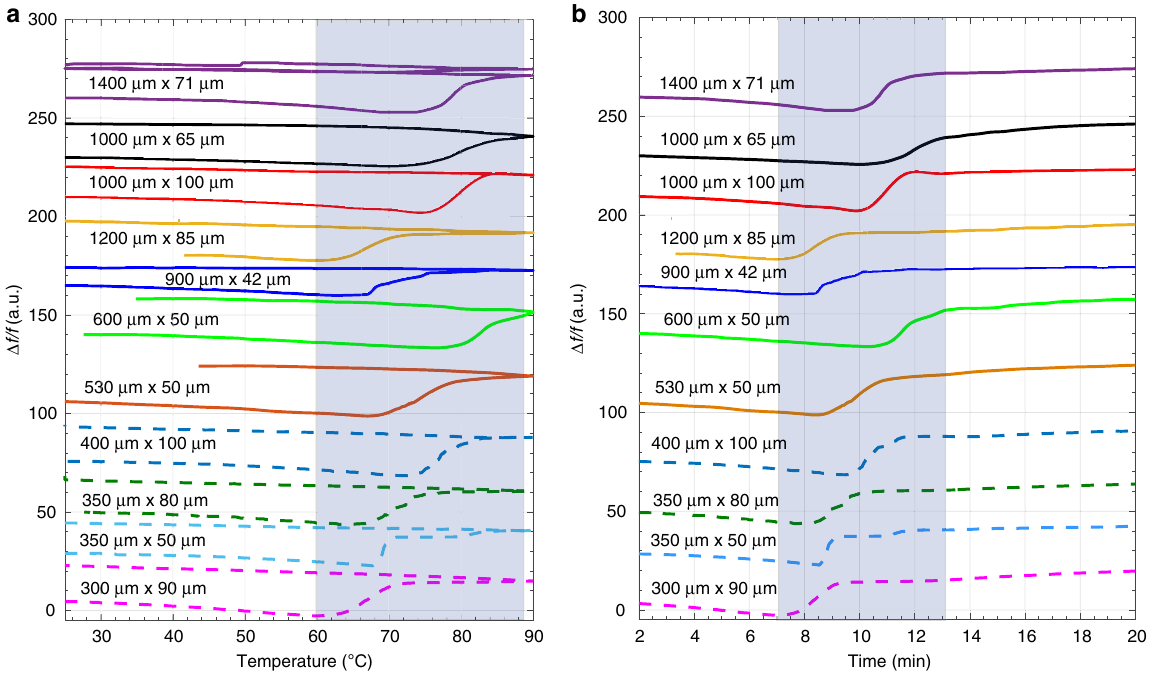
Fig. 4 Reproducibility of PMTA and analysis of different modes of vibration. a PMTA thermograms showing dehydration (25 – 90 – 25 °C, 5 °C/min) of eleven single particles of TP MH, b Time plot of the same eleven particles in Fig. 4a. The dotted lines signify the relatively smaller sized particles in this study. 1400 μ m × 71 μ m particle was exposed to a second thermal cycle (25 – 90 – 25 – 90 – 25 °C, 5 °C/min). The shaded regions in the fi gures highlight the main dehydration transitions of TP